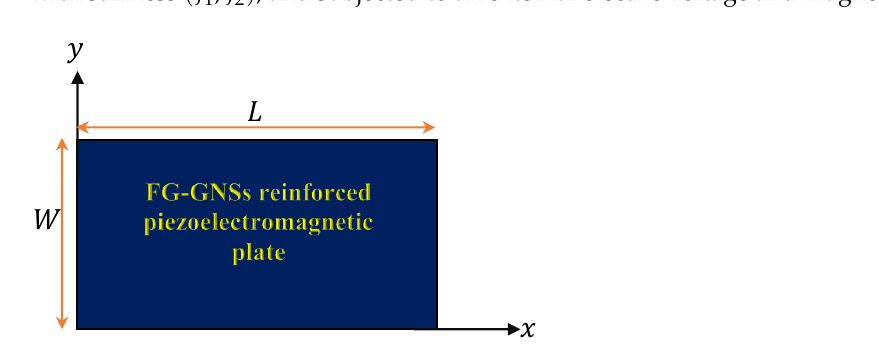
Figure 1. Geometry and coordinates of a naocomposite piezoelectromagnetic